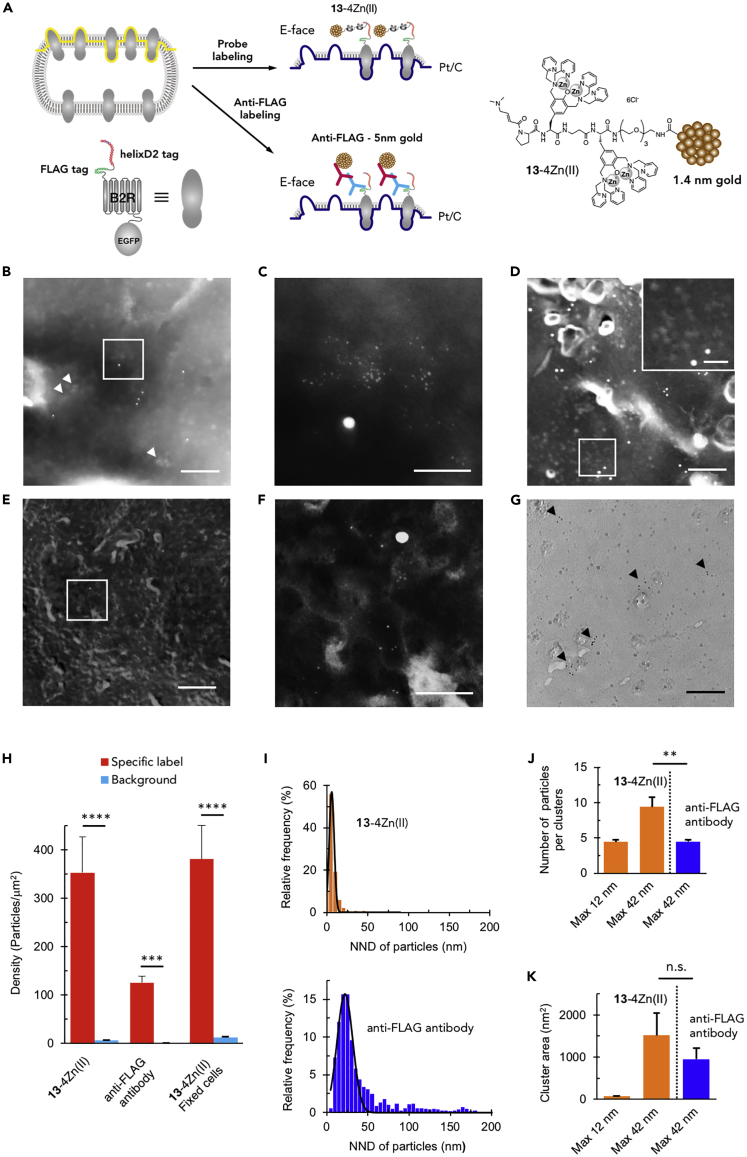
EM Detection of helixD2-Tag-Fused B2R Protein on HEK Cells Using the Probe Conjugated with a 1.4-nm Gold Particle(A) Schematic illustration of labeling states of replicas.(B–D) Dark-field scanning transmission electron microscopy images of E-face replicas made from transfected (B and C) or non-transfected (D) HEK cells labeled with 13-4Zn(II) before aldehyde fixation. (C) and the inset on (D) are magnified images of the area framed in (B) and (D), respectively. White arrowheads indicate B2R clusters labeled with 13-4Zn(II). Scale bar: 200 nm in (B) and the main picture of (D) and 50 nm in (C) and the inset on (D).(E and F) Dark-field images of replicas made from transfected HEK cells labeled with 13-4Zn(II) after aldehyde fixation. (F) A magnified image of the area framed in (E). Scale bar: 200 nm in (E) and 50 nm in (F).(G) Bright-field TEM image of E-face replica labeled with anti-FLAG antibody combined with 5-nm gold-particle-conjugated secondary antibody. Black arrowheads indicate B2R clusters labeled with 5-nm gold particles. Scale bar, 200 nm.(H) Comparison of the specific and background labeling density with 13-4Zn(II) and anti-FLAG antibody. “13-4Zn(II)” and “13-4Zn(II), fixed cells” indicate results from HEK cells labeled before and after aldehyde fixation, respectively (13-4Zn(II), ****p < 0.001, Mann-Whitney U test; specific labeling, n = 9 cells; background labeling, n = 13 cells; mean ± SE, anti-FLAG, ***p < 0.005, Mann-Whitney U test; specific labeling, n = 7 cells; background labeling, n = 7 cells; mean ± SE, 13-4Zn(II), fixed cells, ****p < 0.001, Mann-Whitney U test; specific labeling, n = 11 cells; background labeling, n = 15 cells; mean ± SE).(I) Distribution histograms of nearest neighbor distance (NND) of gold particles observed on replicas labeled with 13-Zn(II) (upper, n = 1748 particles) and anti-FLAG antibody (bottom, n = 998 particles). Fitted lines show Gaussian distribution fitting for the peaks.(J) Comparison of the number of particles per B2R cluster labeled with 13-4Zn(II) and anti-FLAG antibody. “Max 12 nm” and “Max 42 nm” mean the maximum NND of gold particles used for the definition of clusters labeled with 13-4Zn(II) and anti-FLAG antibody (13-4Zn(II) Max 12 nm; n = 10 cells, 13-4Zn(II) Max 42 nm, n = 10 cells; anti-FLAG Max 42 nm, n = 7 cells, mean ± SE, **p < 0.01, Mann-Whitney U test).(K) Comparison of the B2R cluster area evaluated by chemical labeling with 13-4Zn(II) and immunolabeling with anti-FLAG antibody (13-4Zn(II) Max 12 nm; n = 10 cells; 13-4Zn(II) Max 42 nm, n = 10 cells; anti-FLAG 42 nm, n = 7 cells; mean ± SE, n.s. p > 0.05, Mann-Whitney U test).